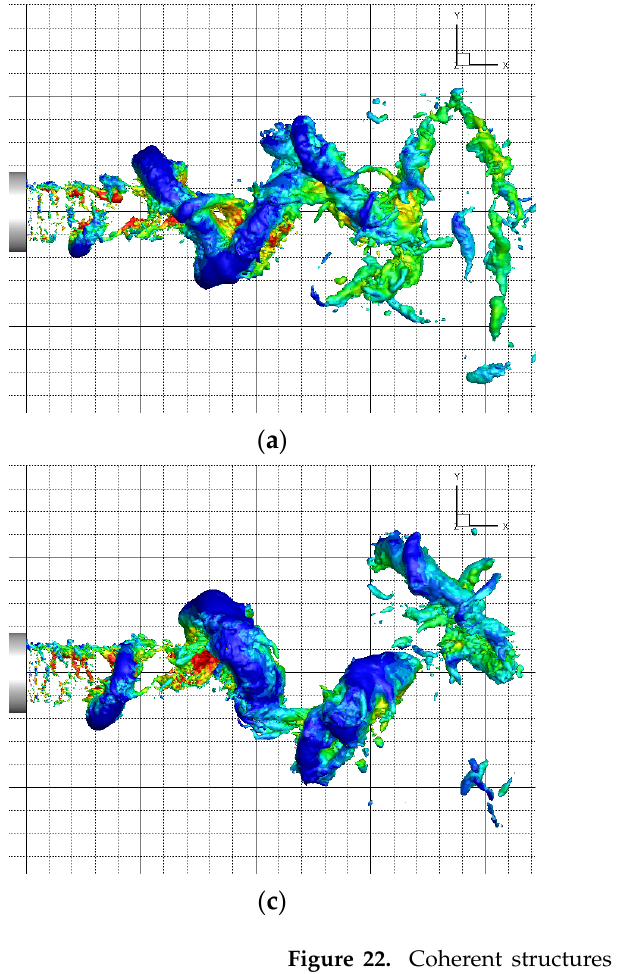
Figure 21. Velocity decay metric U * versus frequency for different amplitudes.